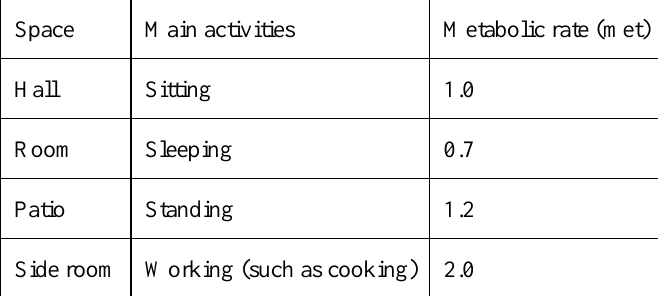
Table 3. The metabolic rate for thermal comfort